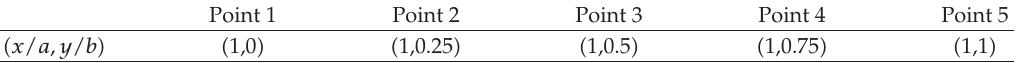
Table 5: Dimensionless coordinates of points selected on the plate free edge for studying amplitude of limit-cycle oscillations. Point